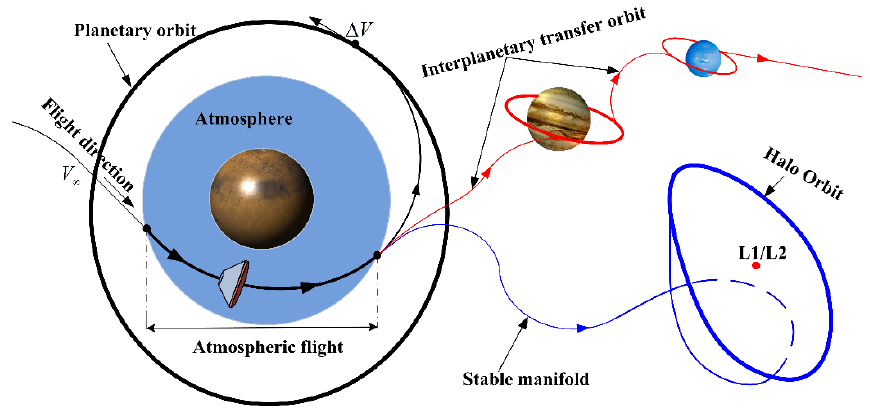
Figure 1. Potential missions achieved by aerocapture.